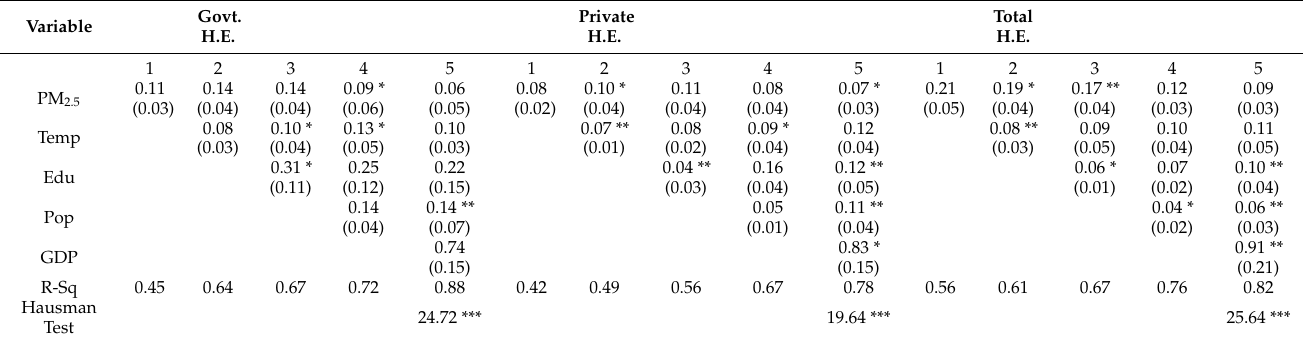
Table 3. Results (Panel Fixed Effect Model).